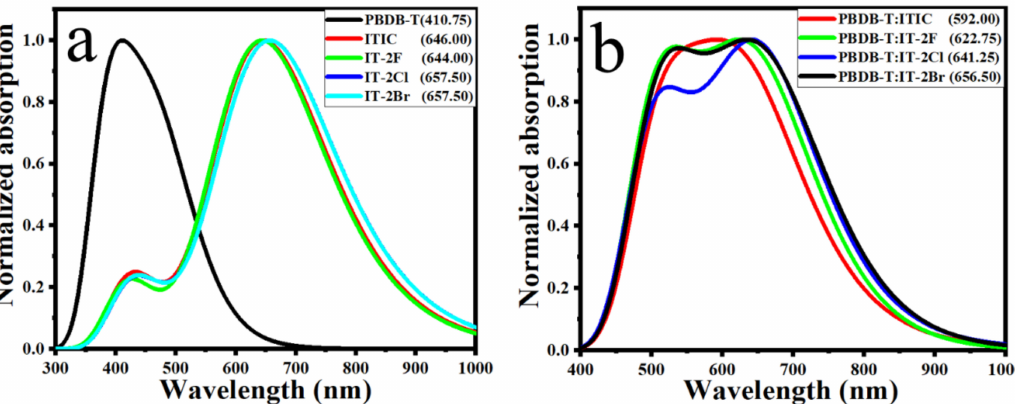
Figure 2. The simulated absorption spectra of electron donor PBDB-T, electron acceptors ITIC and IT-2X (X = F, Cl, Br) ( a ) and the donor/acceptor complexes ( b ) in solid phase. The half-width at half-maximum of 0.330 eV ( a ) and 0.255 eV ( b ) were applied for absorption spectra simulations. The wavelengths (in nm) at absorption maxima are marked in the figure. (LC-PBE/6–31G**; α = 0.200, β = 0.086; ε s = 3.5, ε d =